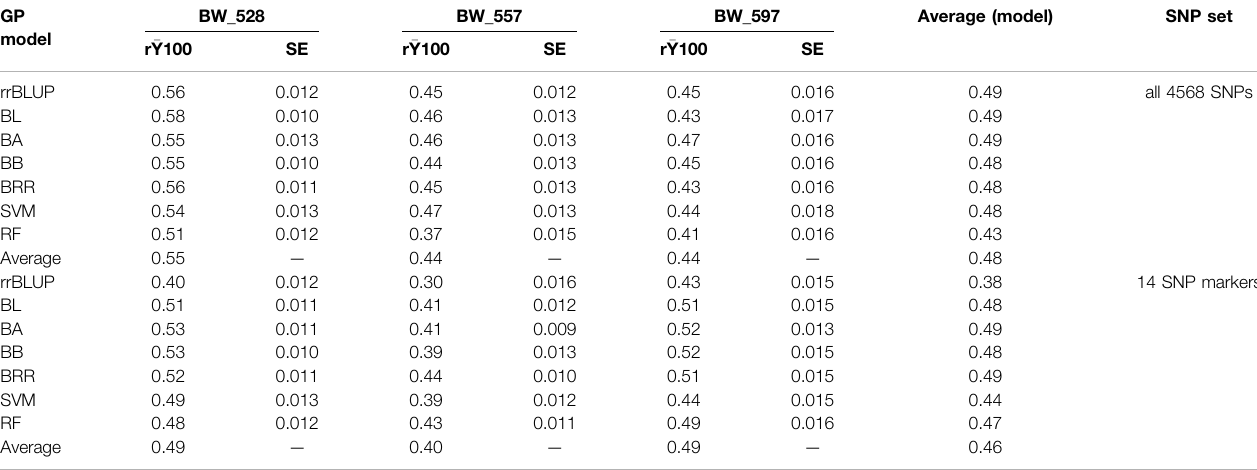
TABLE 3 | Genomic prediction of seven models for resistance to three bacterial wilt (BW) isolates in two SNP sets: 1) all 4,568 SNPs and 2) 14 SNP markers. GP